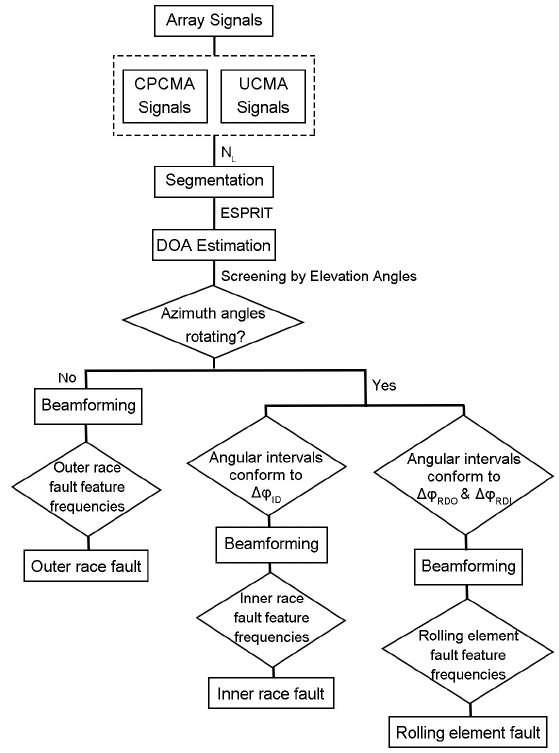
Figure 7. Signal processing and analysis procedure.